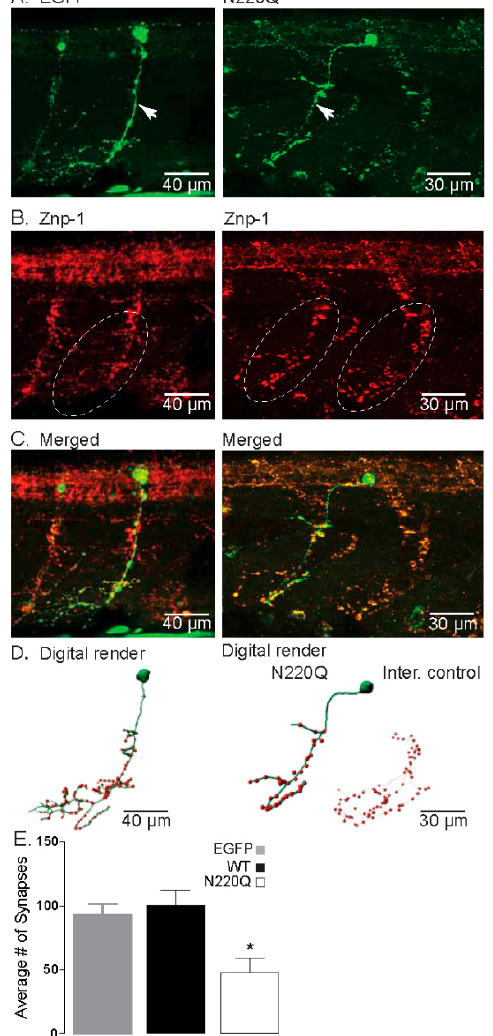
Figure 2. N-Glycosylation processing of the Kv3.1b protein impacts motor neuron development in zebrafish. ( A ) Confocal images of IHC staining of CaP neurons expressing either EGFP ( left ) or N220Q Kv3.1b ( right ) from 48 hpf embryos. Arrows denote main axonal branches. ( B ) Co-staining of Znp-1 highlights the extensive synapse points in the ventral myotome (dashed line oval). ( C ) Merged confocal projections from parts A and B, illustrating the lack of branches and lowered synapse numbers of CaP neurons expressing the N220Q Kv3.1b compared to EGFP alone or internal control. ( D ) Digital rendering of neuron morphology (green) and synaptic points (red) from part C, showing the extensive axonal branching of EGFP expressing neurons and internal control and high synaptic points compared to the CaP neuron expressing the N220Q Kv3.1b. ( E ) Average number of synapses of CaP neurons expressing EGFP ( n = 10), WT ( n = 8) and N220Q ( n = 9) Kv3.1b proteins. Graphs denote mean ± SEM and were compared by Student’s t-test (* p < 0.0087). See also Movies Figures S4 and